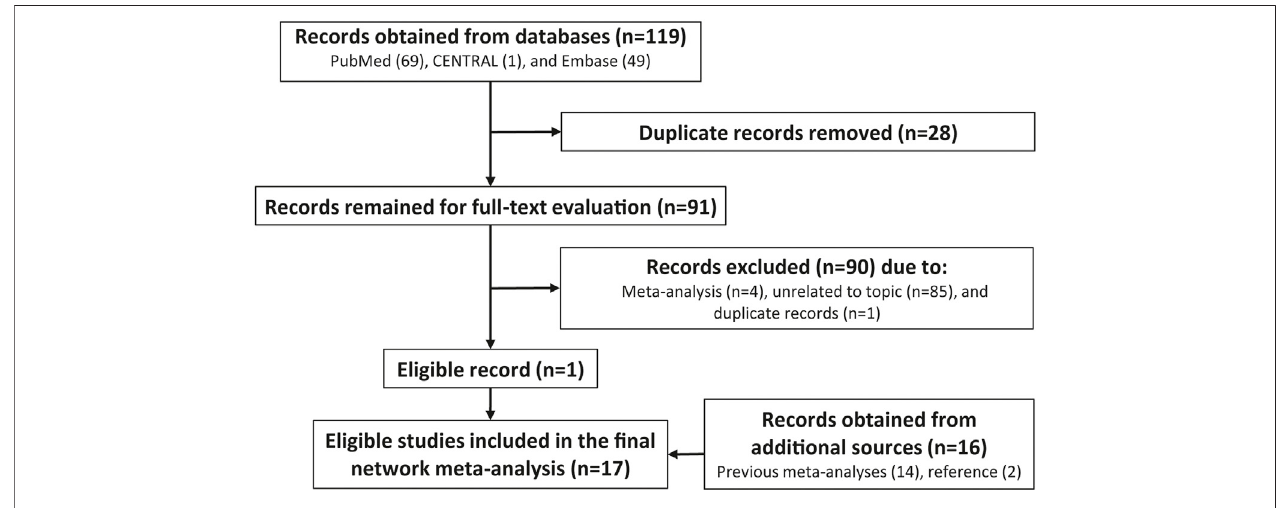
FIGURE 1 | Flowchart of identi fi cation and selection of eligible